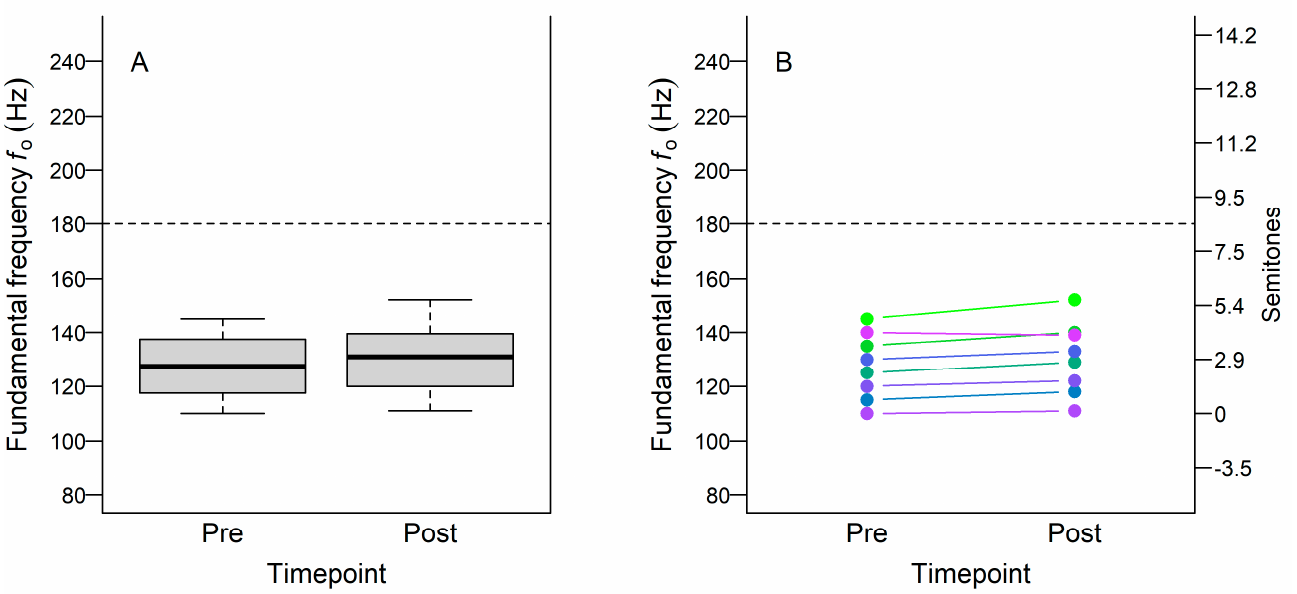
Figure 1. Example 1. Panel A ( left ): Boxplots over an example sample’s fundamental frequencies (in Hz) before ( pre ) and after ( post ) training. A boxplot illustrates quartiles; the central black thick line is the median, the upper and lower limit of the box are the 25th and 75th percentile, and the lower and upper whiskers indicate minimum and maximum values. Panel B ( right ): Individual treatment “trajectories”. Each participant’s pre and post measure is color-coded per participant and illustrated with a circle connected by a straight line. In both figures, 180 Hz is illustrated as a horizontal dashed line because it has been suggested to be fundamental frequency range relevant for being perceived as a female speaker [24–26] which is the goal of the participants. Semitones are illustrated in the right-hand panel of Panel B as number of semitones above 110 Hz. Table 1. Example 1. Each individual’s average fundamental frequency (in Hz) before ( pre ) and after ( post ) treatment. The right-most column is the post minus pre difference in Hz. Further illustrated are the mean and standard deviation for each column. Because the inter-individual variation in the difference scores is so small and most participants have a small, positive effect, a t -test applied to